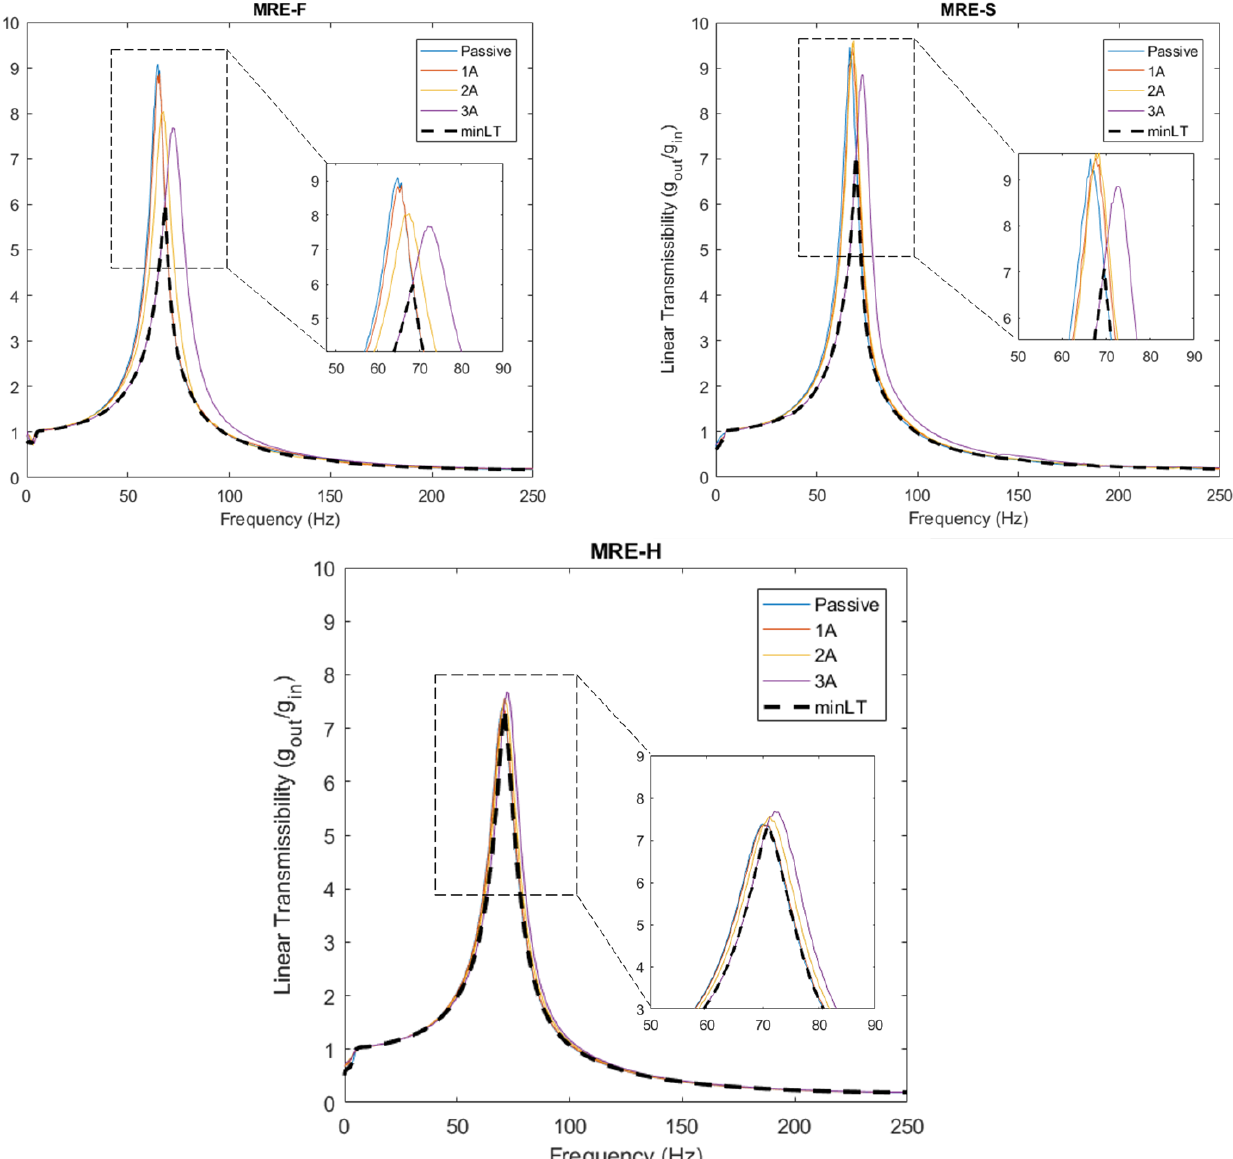
Figure 13. The linear transmissibility factor for MRE-F, MRE-S, and MRE-H.